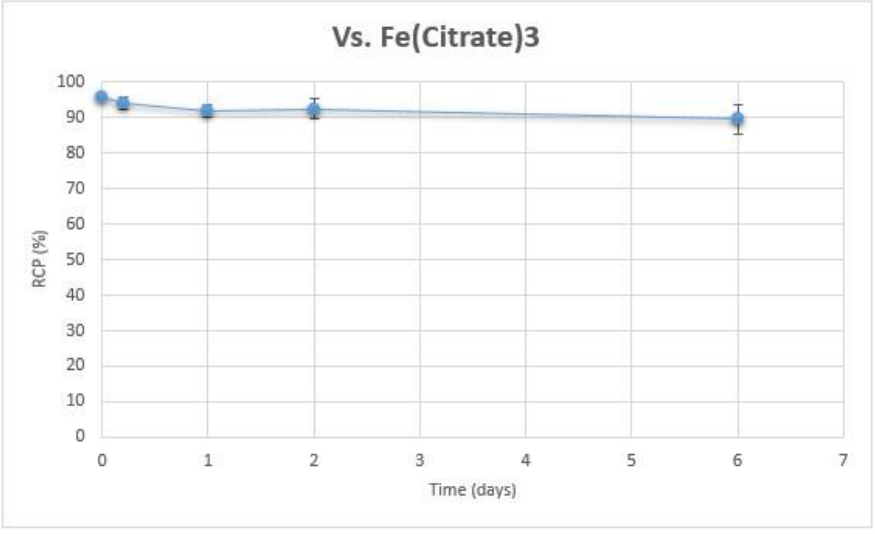
Figure 6. Stability of 90 Y-Hinokitiol vs. 100 mM Fe(citrate) 3 .